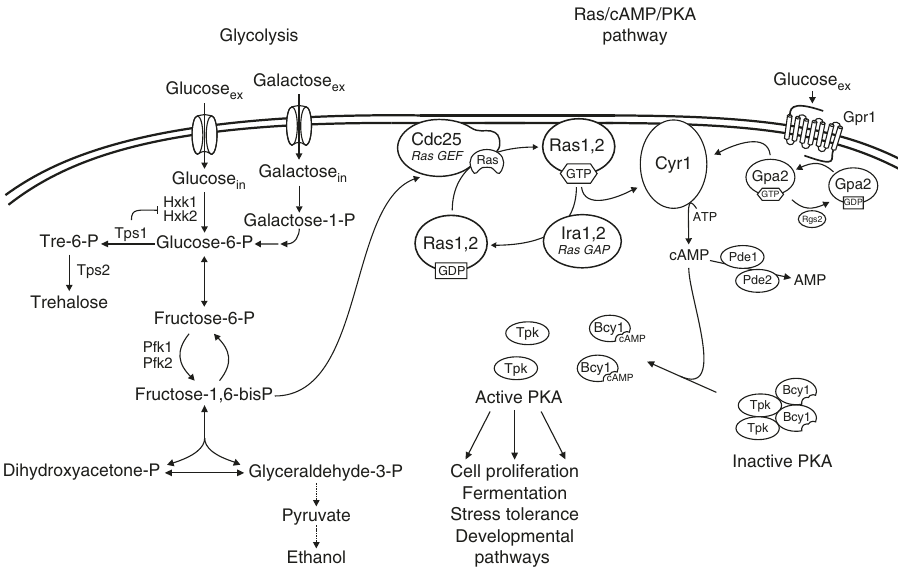
Fig. 1 Schematic overview of initial glucose metabolism in yeast and its connection to activation of the Ras-cAMP-PKA pathway. Extracellular glucose is transported by facilitated diffusion into the cells after which it is phosphorylated by one of the two hexokinases or by glucokinase. The activity of the two hexokinases, but not glucokinase, is feedback-inhibited by Tre6P, the intermediate in trehalose biosynthesis. Glu6P is further converted into Fru6P, Fru1,6bisP, the triose phosphates DHAP and GAP, and the latter is subsequently converted to pyruvate and the fermentation product ethanol. Galactose is taken up by its own carrier, phosphorylated to Gal1P and further converted into Glu6P, where it joins the glucose catabolic pathway, effectively bypassing the hexokinase catalyzed step in glycolysis. The Ras-cAMP-PKA pathway exerts major control over cell proliferation, fermentation rate, stress tolerance and developmental pathways in yeast. As in mammalian cells, cAMP is synthesized by adenylate cyclase (Cyr1) and binds to the Bcy1 regulatory subunits of PKA, causing their dissociation from the catalytic Tpk subunits with activation of the latter as result. Yeast adenylate cyclase is activated by a glucose- sensing G-protein coupled receptor (GPCR) system, composed of the Gpr1 receptor, the G α protein Gpa2, and its GAP factor Rgs2, similar to activation of adenylate cyclase by GPCR systems in mammalian cells. As opposed to mammalian cells, however, yeast adenylate cyclase is also activated by the Ras1,2 proteins, which are controlled by the Cdc25 (and Sdc25) guanine nucleotide exchange factor (GEF) and the GTPase activating proteins (GAP) Ira1,2. Ras and its regulators are highly conserved between yeast and mammalian cells (the GEF Sos and the GAP NF1, respectively). Although it was known that glucose catabolism in glycolysis is required for glucose activation of the Ras proteins and cAMP synthesis, the molecular connection remained unknown. In the present paper, it is shown that Fru1,6bisP functions as activator of Ras by interacting with Cdc25 and that this connection between glycolysis and Ras is conserved between yeast and mammalian